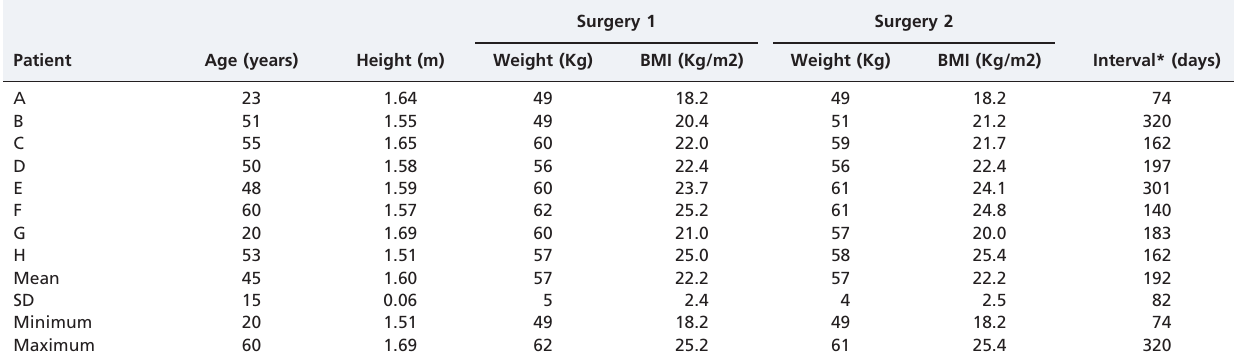
Table 1 - Demographic data and patient statistics (n=